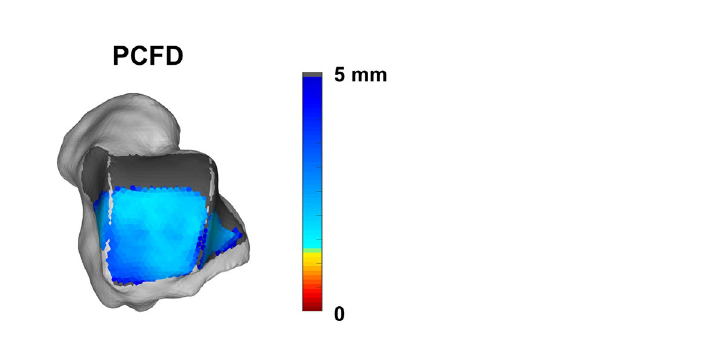
Figure 2. The tibiotalar joint was analyzed with respect to the talus (shown here from above) divided into a 3 × 3 grid using the principal axes of the joint surface for more detailed distance map and coverage map analyses (Disior Ltd, Bonelogic 1.0, Helsinki, Finland). The medial and lateral ankle joint gutters were also divided into anterior and posterior regions using the principal axes.